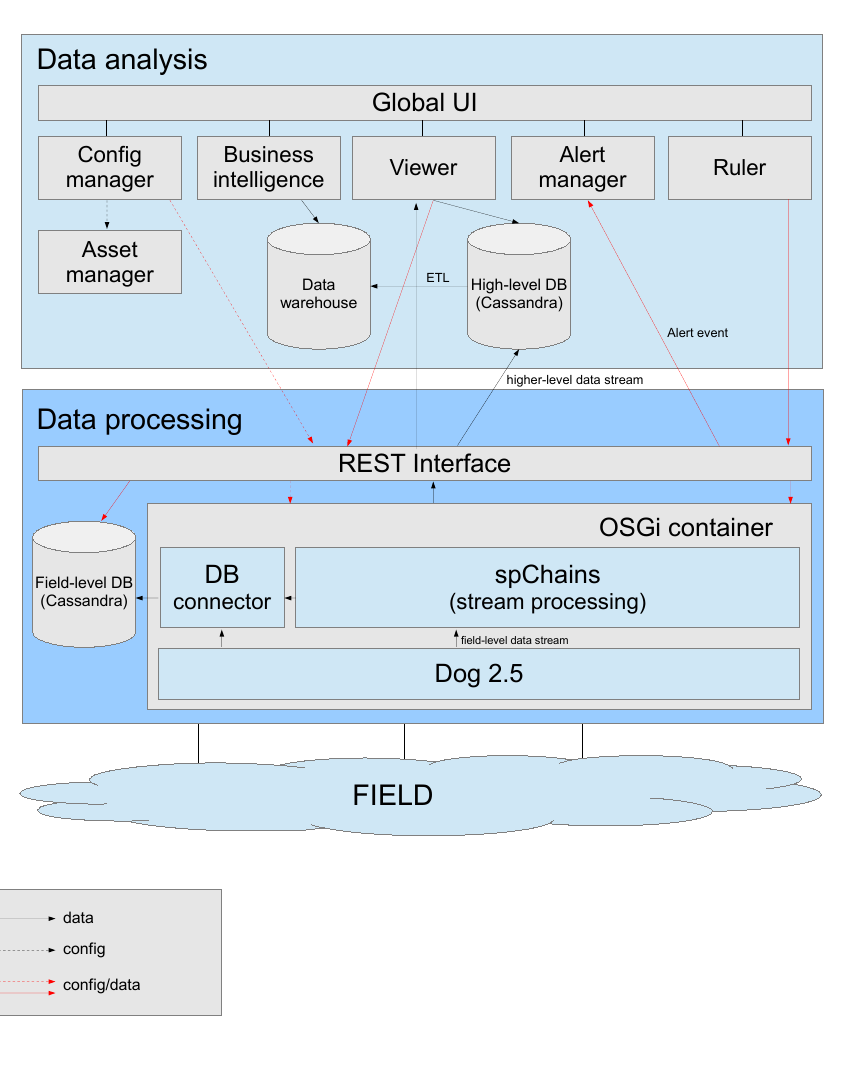
Figure 10. IT architecture for the Applus